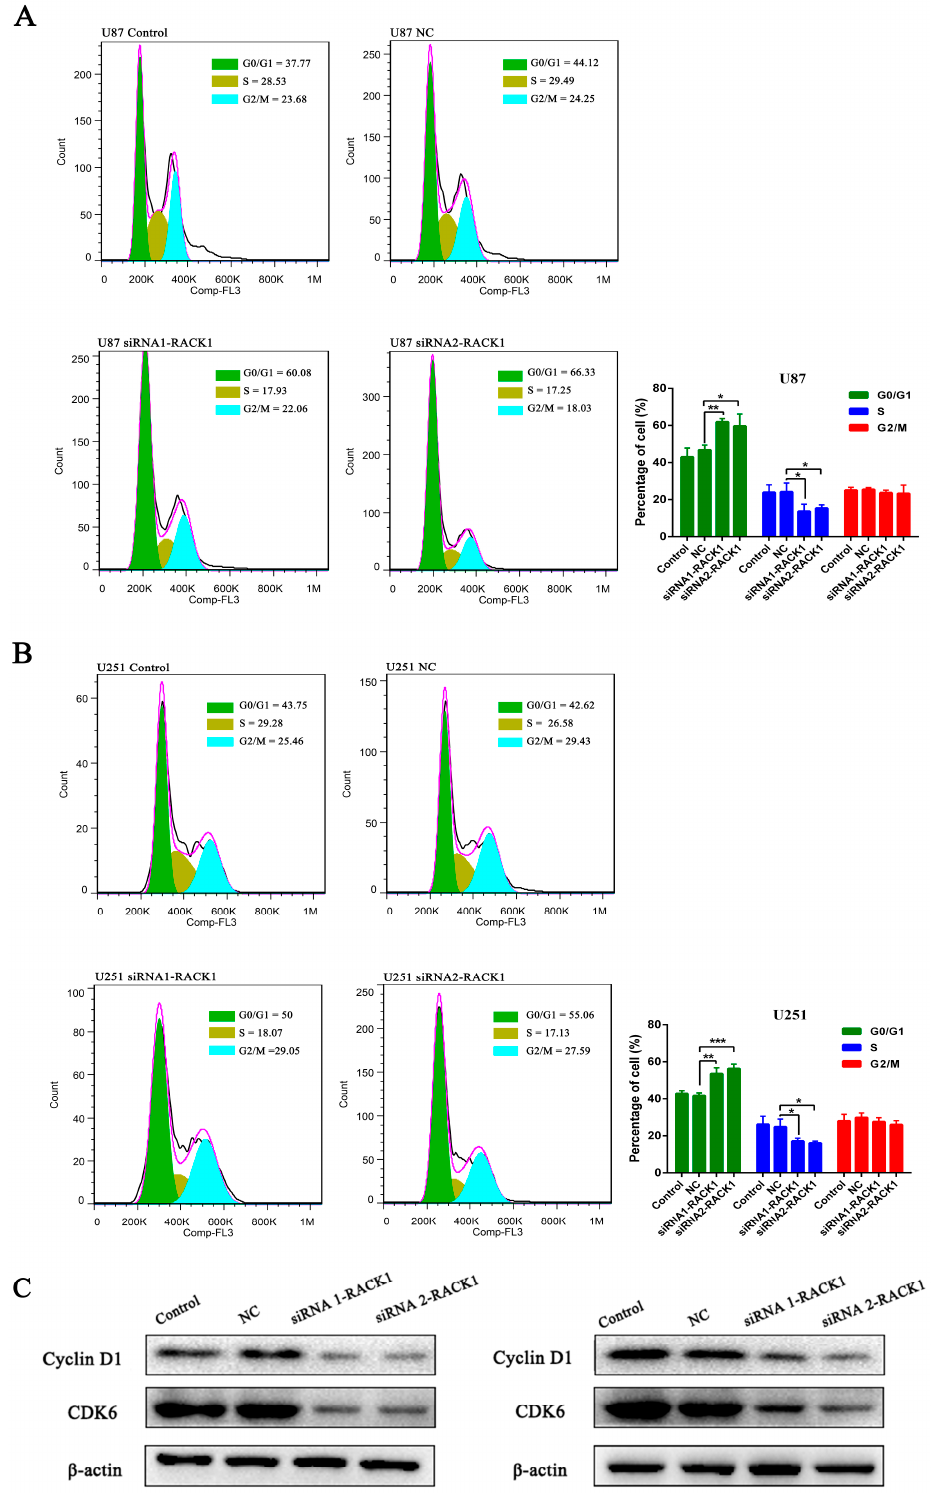
Figure 4. The effect of RACK1 on glioma cell cycle. ( A , B ) Down-regulation of RACK1 led to a dramatic accumulation of cells in G0/G1 phase and their obviously reduced proportions at the S phase (* p < 0.05, ** p < 0.01, *** p < 0.001); ( C ) Western blot analysis was performed to determine the expressions of Cyclin D1 and CDK6 both in U87 and U251 cell lines.